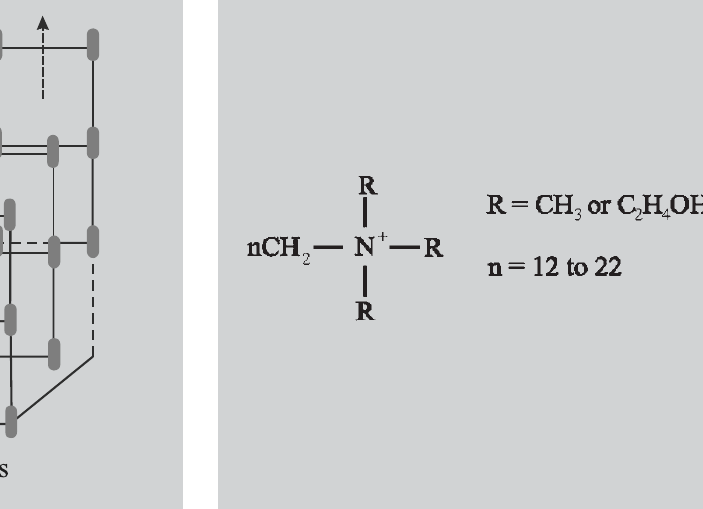
Figure 2 (left): Viscoelastic structure, SIS, and alignment of micelles in flow direction [20]. Figure 3: Chemical structure of quaternary ammonium cationic